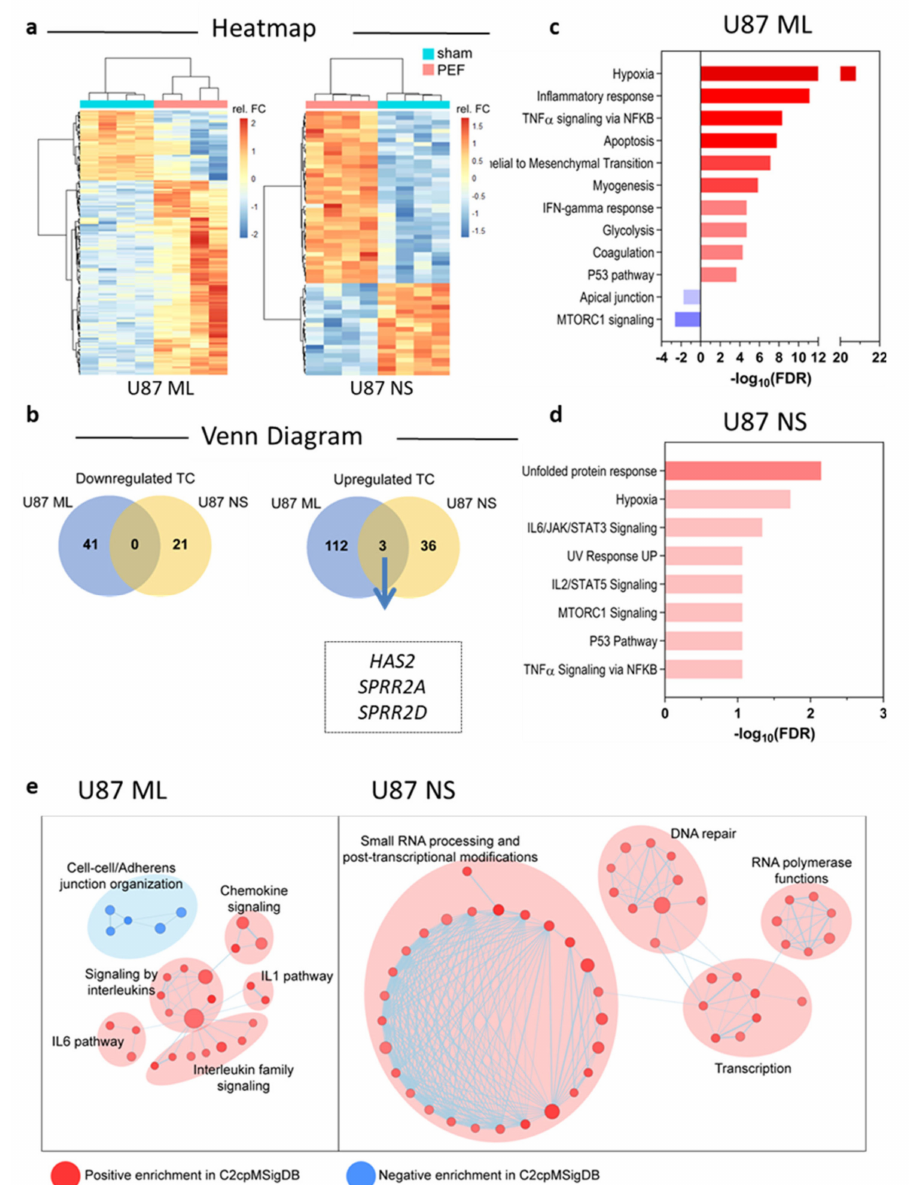
Figure 3. Transcriptomic analysis. ( a ) Heat maps displaying differentially expressed genes in U87 ML and NS cells. ( b ) Venn diagram depicting the number of significantly downregulated and upregulated genes in ML and NS U87 cells, as well as the name of commonly upregulated genes. ( c , d ) Bar graphs displaying the positive (red) and negative (blue) transcriptional enrichments in MSigDB gene sets of differentially expressed genes between sham-exposed and PEF5-exposed U87 ML and U87 NS cells. ( e ) Enrichment maps displaying transcriptional enrichments in cellular remodeling and inflammation processes in U87 ML cells and in DNA repair and RNA processing and post-transcriptional modification in U87 NS